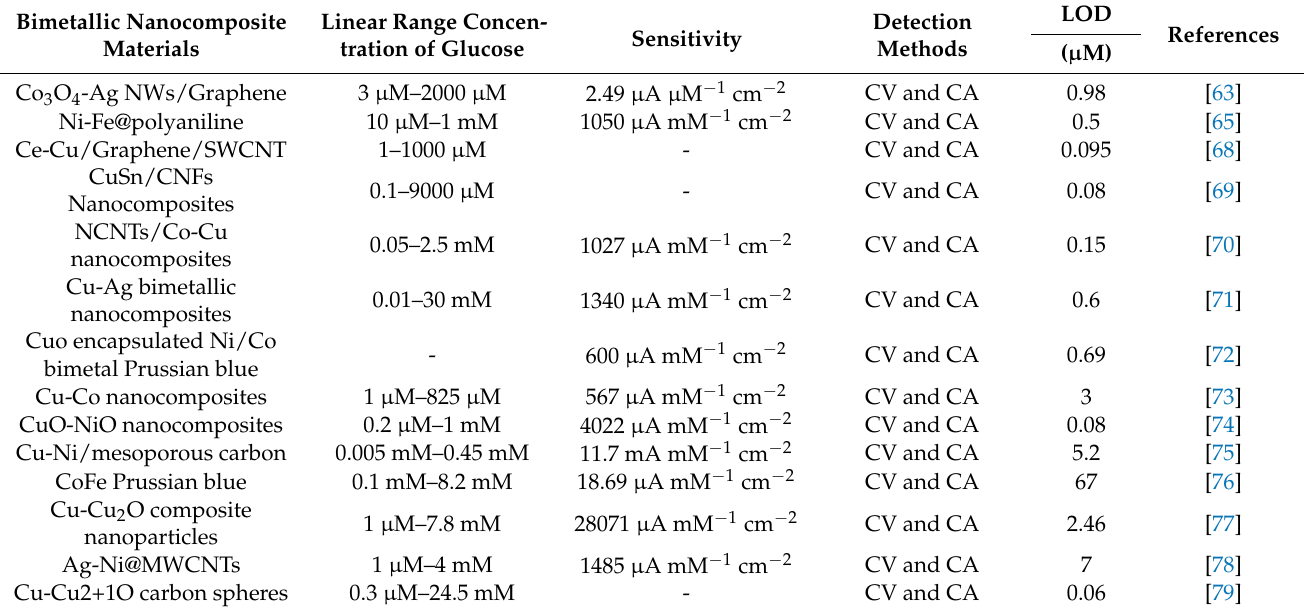
Table 2. Bimetallic nanocomposite materials based glucose sensor fabrication schemes and their analytical